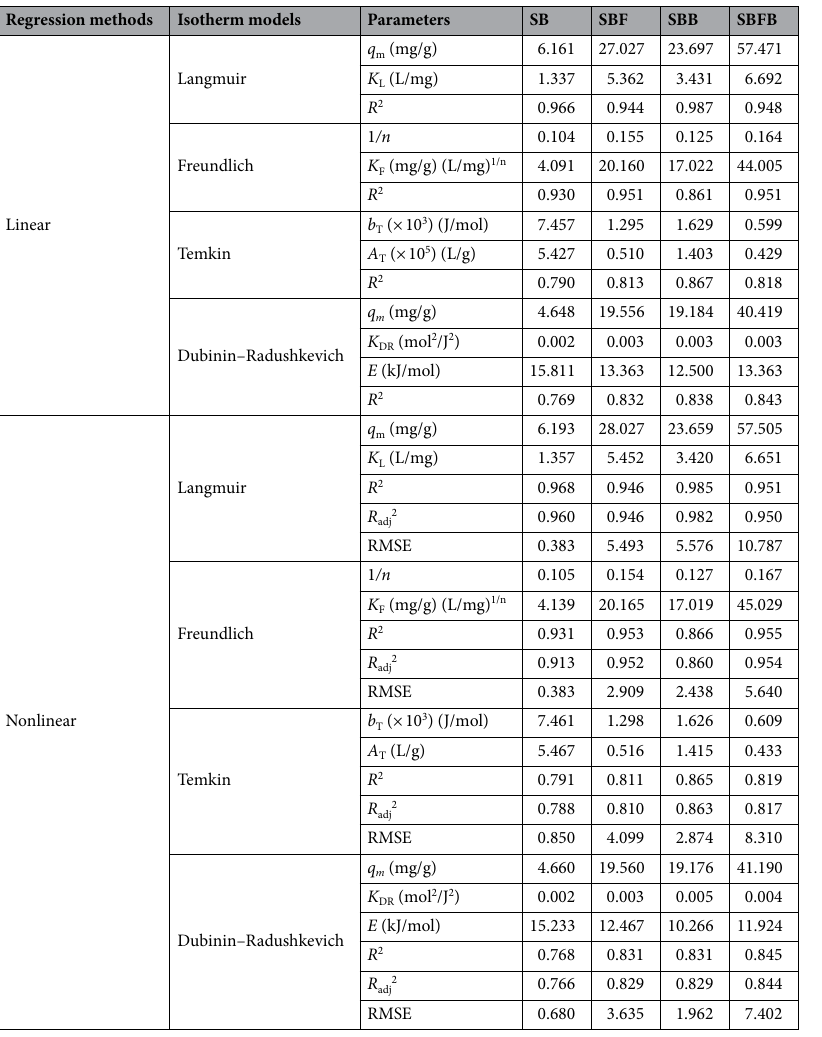
Table 3. The comparison of linear and nonlinear isotherm parameters for lead adsorptions on sugarcane bagasse powder (SB), sugarcane bagasse powder doped iron(III) oxide-hydroxide (SBF), sugarcane bagasse powder beads (SBB), and sugarcane bagasse powder doped iron(III) oxide-hydroxide beads